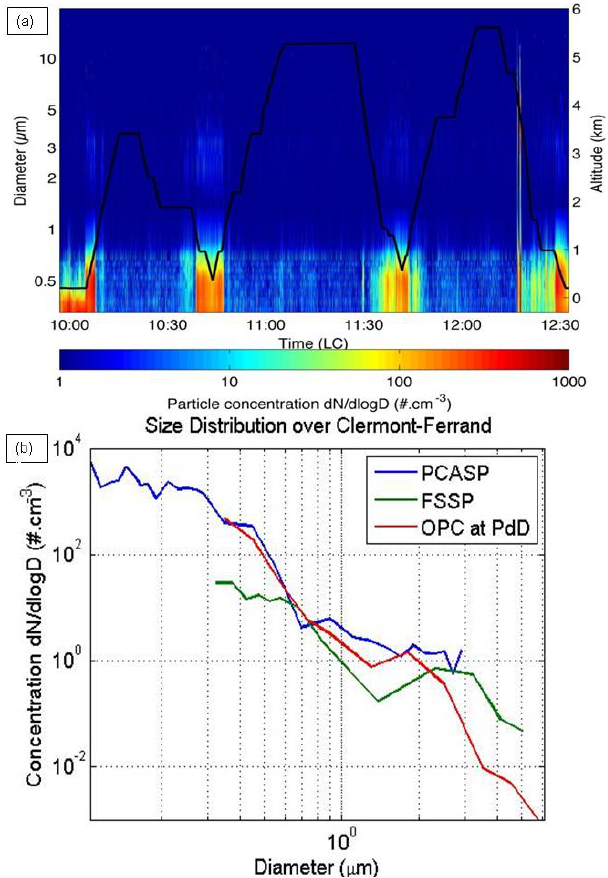
Fig. 12. Aircraft measurements on 22 April. Panel (a) presents the FSSP aerosol size distributions as a function of time. Particle number concentrations are colour-coded and the flight altitude is added in black. Plot (b) shows the mean aerosol size distributions in the PBL of Clermont-Ferrand measured during the overpass by the PCASP (in blue) and the FSSP (in green) and the ground-based OPC (in red).